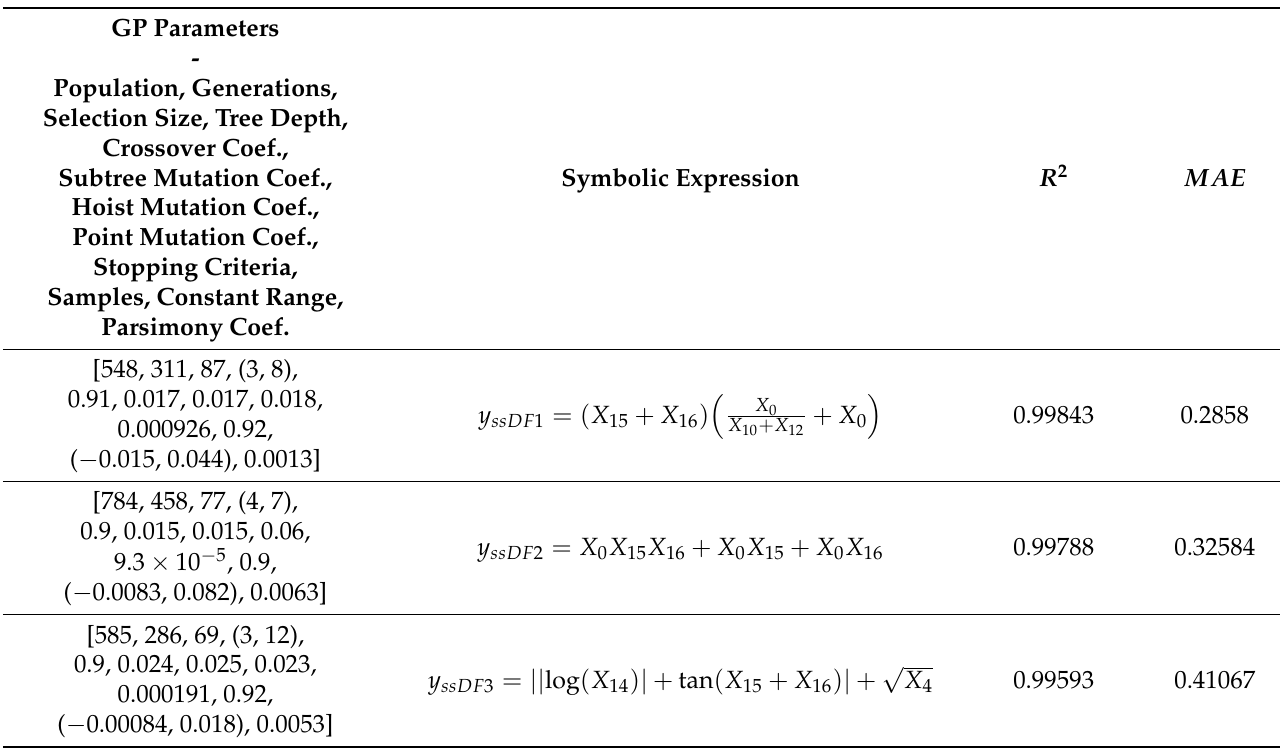
Table 6. Three best symbolic expressions for ship speed estimation with decay state coefficients with corresponding R 2 and MAE score.